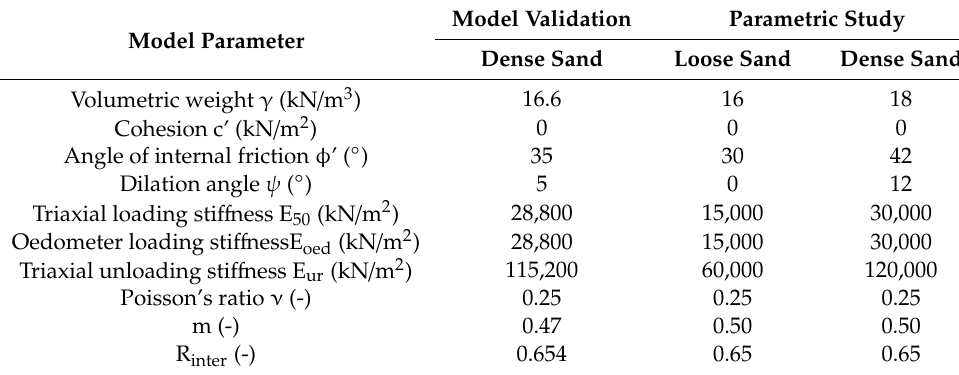
Table 3. Hardening soil model parameters for the “synthetic soils”, compared with the parameters of validated numerical model.